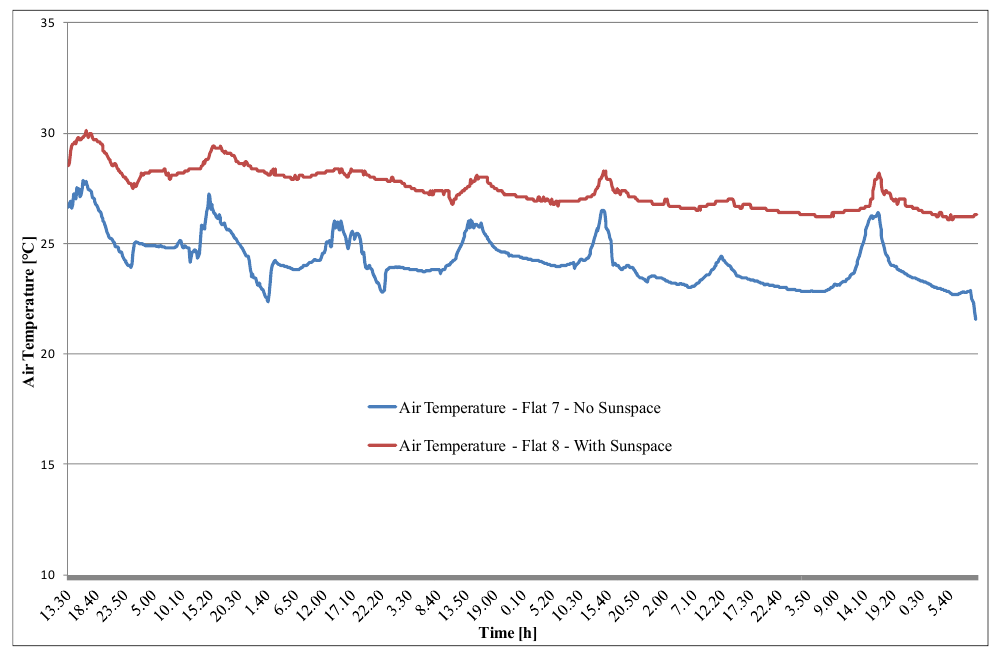
Figure 8. Trends of internal air temperature in two flats, with and without sunspace.